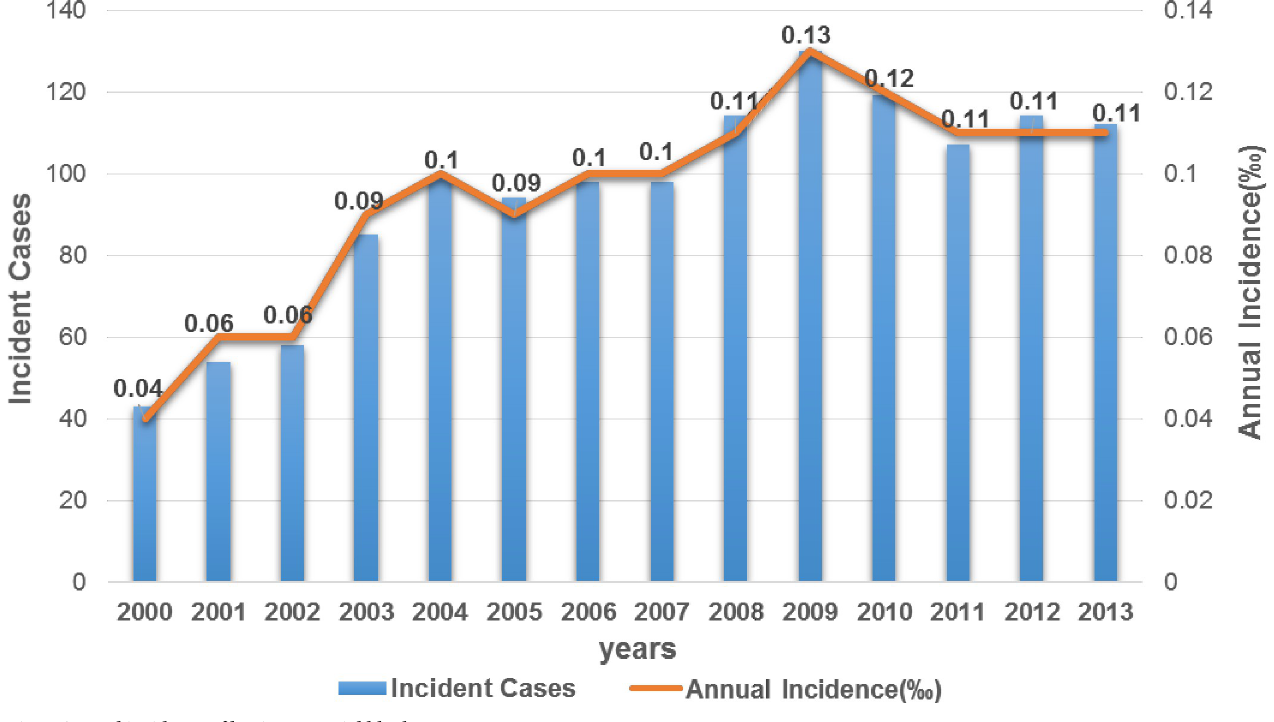
Fig 1. Annual incidence of benign essential blepharospasm,